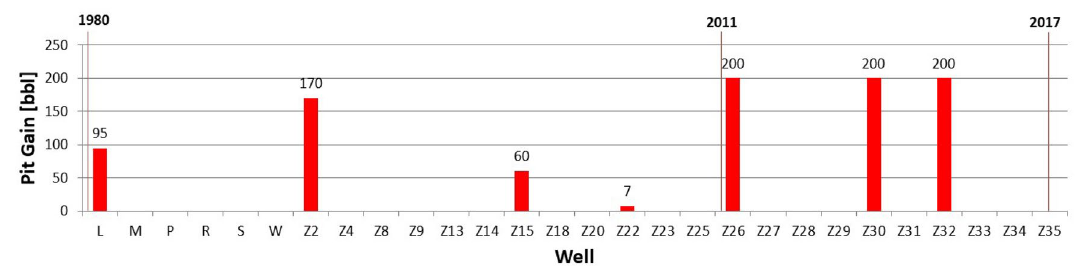
Fig. 3 Pit gains in Gachsaran formation in different wells of Kupal field